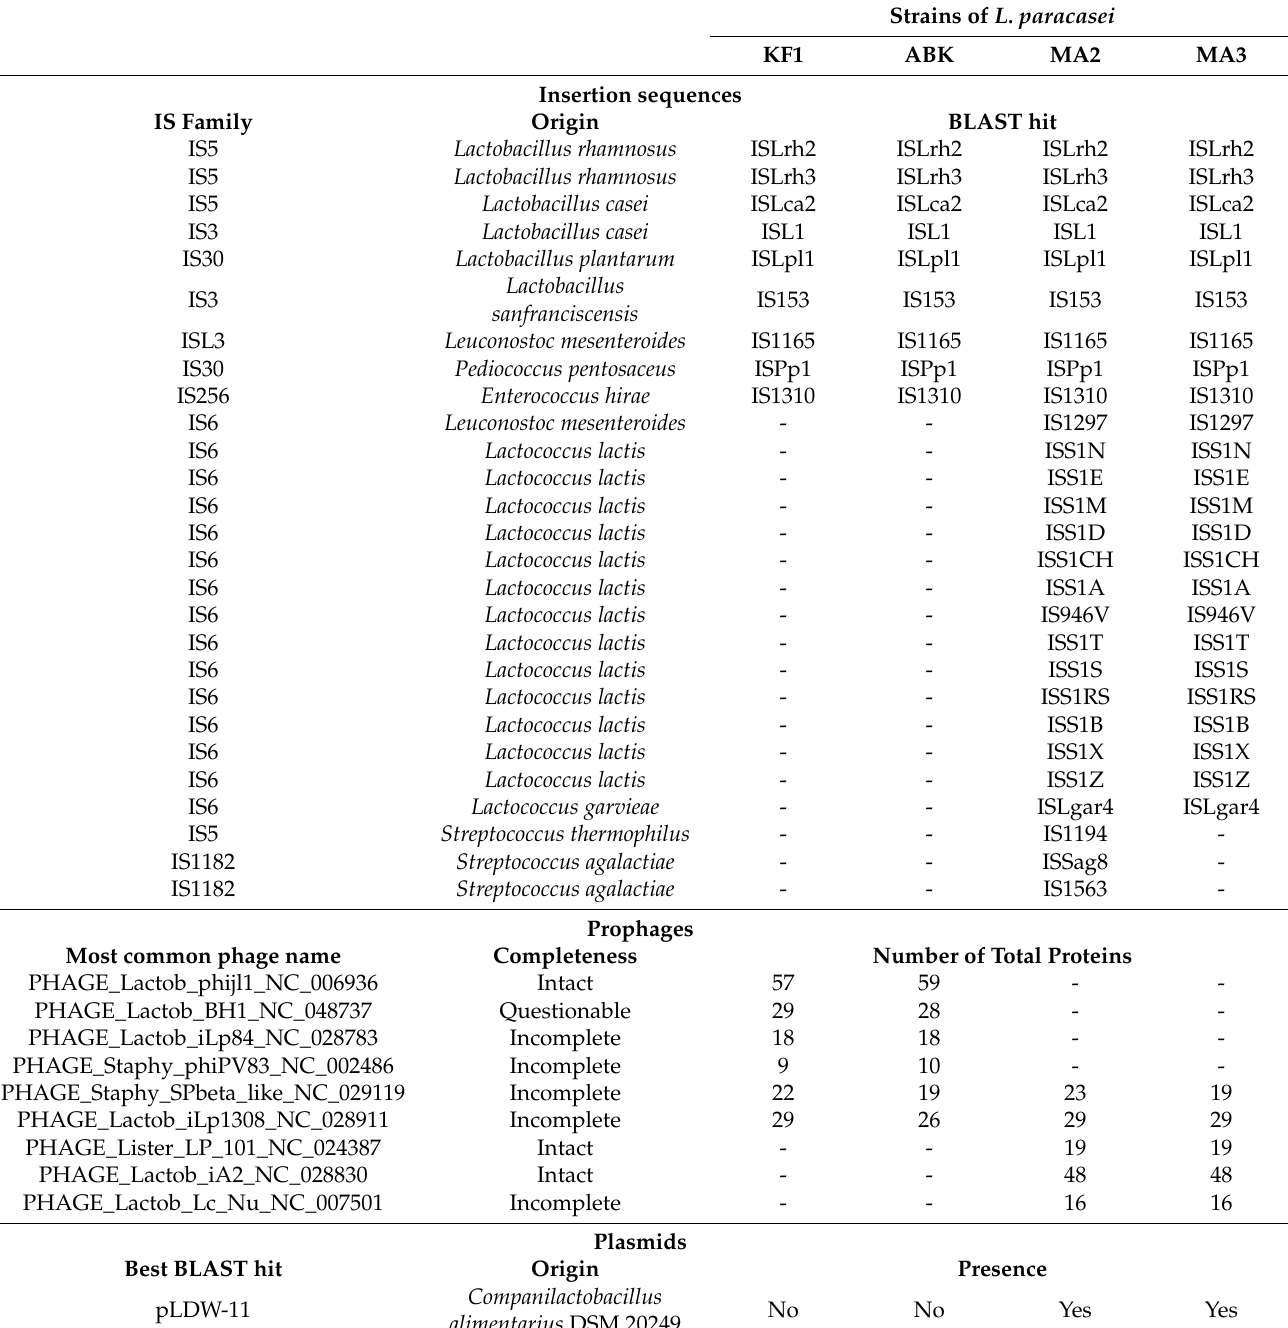
Table 3. Data on the genome stability of the kefir-derived (KF1 and ABK) and mahewu-derived (MA2 and MA3) strains of L. paracasei